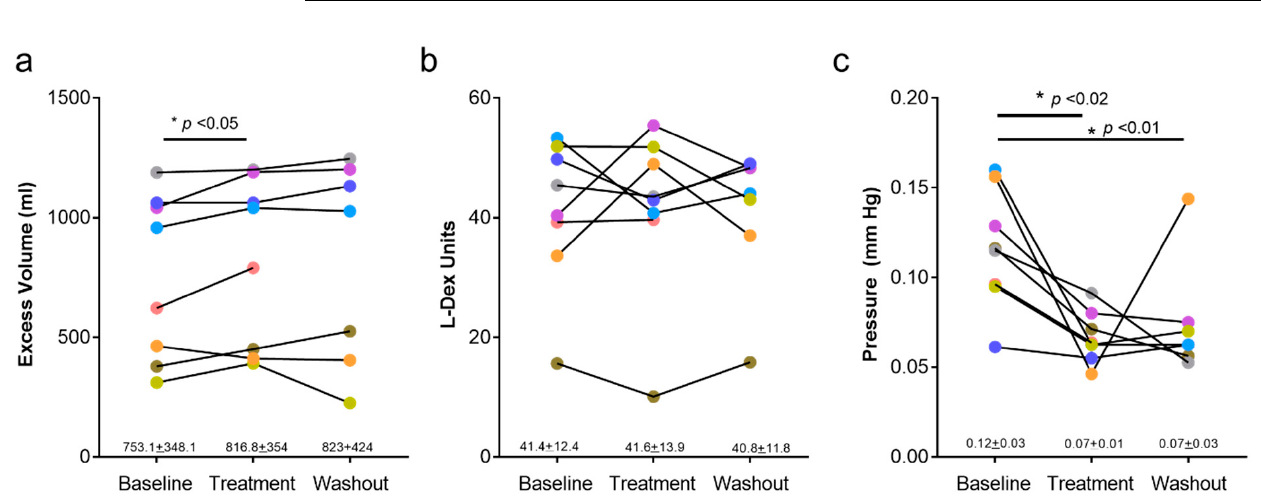
Figure 1. Effects of QBX258 treatment on arm volume, bioimpedance (L-Dex), and tonometry measurements. ( a ) Quantifi- cation of arm volumes at baseline, following 4-month treatment with QBX258 (treatment), and 4 months after cessation of treatment (washout). Changes in each patient are shown over time. ( b ) L-Dex measurements at baseline, following treatment, and following washout period with QBX258. ( c ) Tonometry measurements at baseline, following treatment, and following washout period with